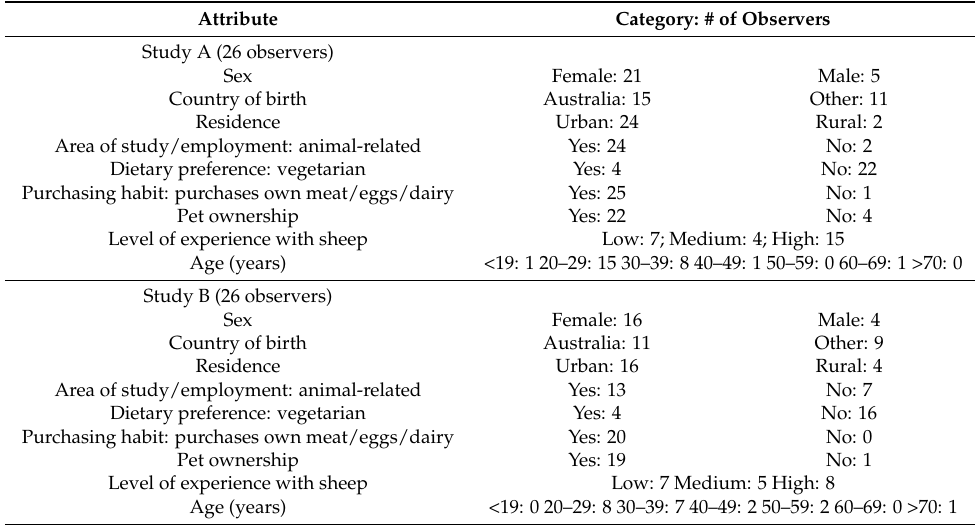
Table 2. Demographic description of observers that contributed to QBA